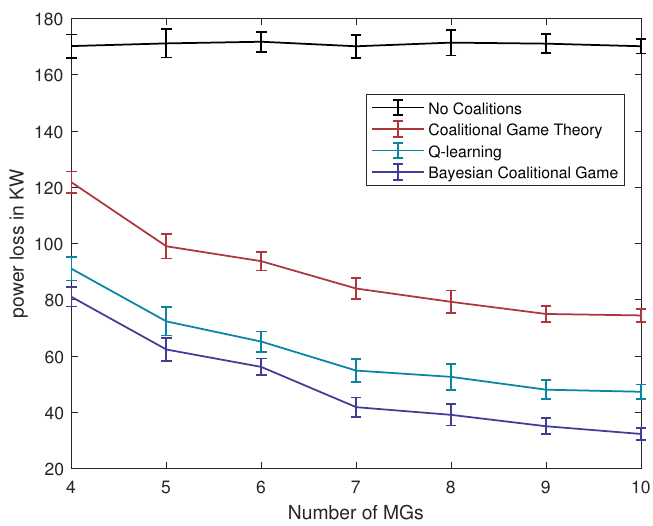
Figure 2. Average loss per user versus the number of MGs with a 95% confidence interval.